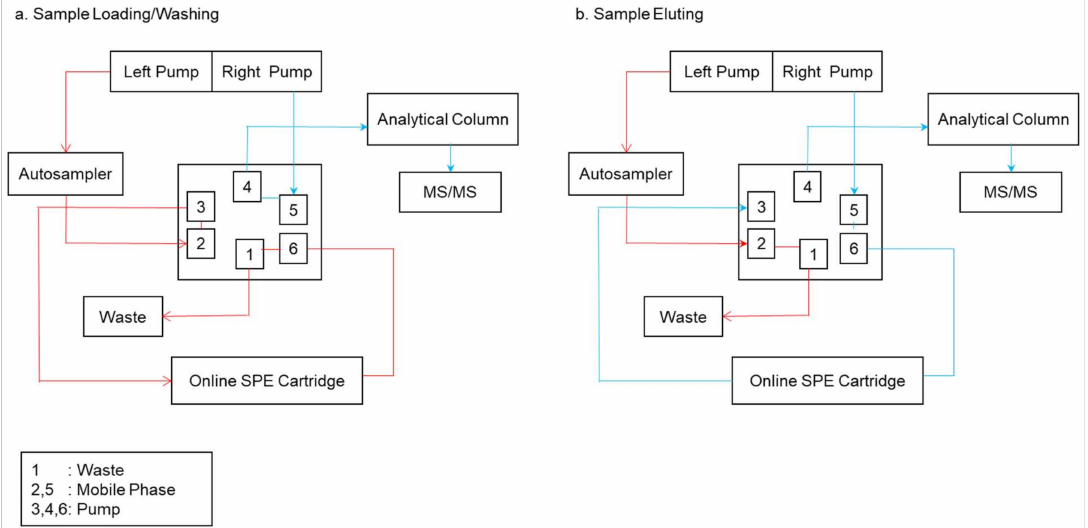
Figure 15. Molecular imprinted solid-phase extraction (MISPE) steps in online mode ( a ) Sample Loading/Washing; ( b ) Sample Eluting